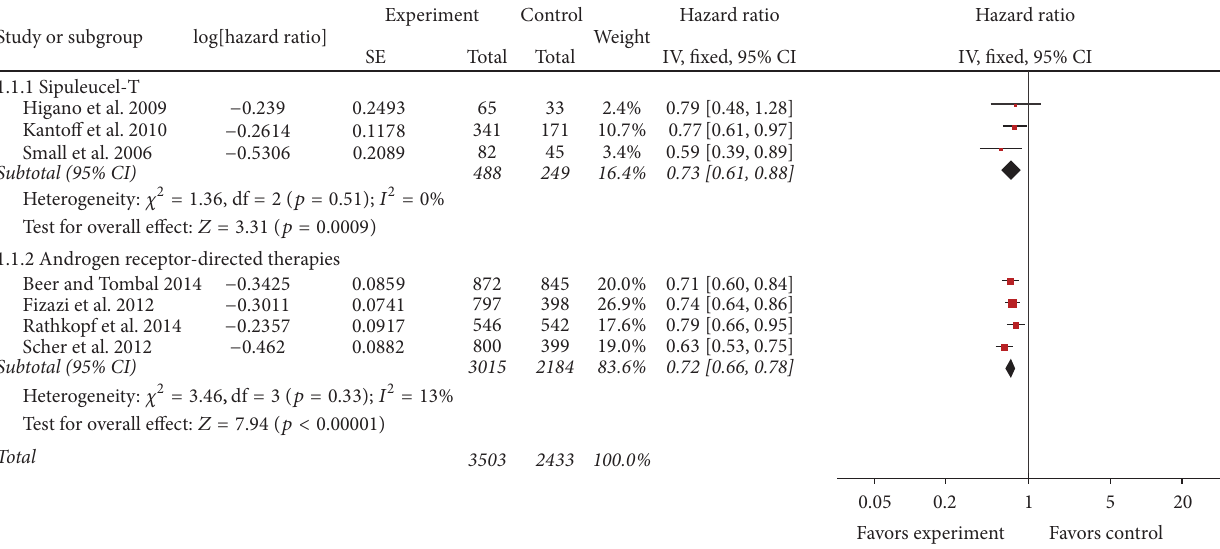
Figure 2: Forest plot of hazard ratio of overall survival of sipuleucel-T and androgen receptor-directed therapies compared with placebo in men with castration-resistant prostate cancer. The bars with squares in the middle represent 95% confidence intervals (95% CIs) and HRs. The central vertical solid line indicates the HRs for null hypothesis. The size of the diamonds represents the weight for the random-effect model in the